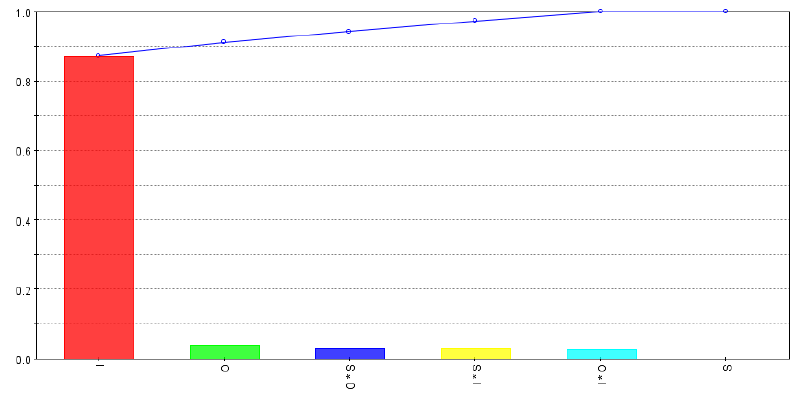
Figure 7. Relative strength of input variables and their interactions for top width error ( 𝜖 𝑡 ).